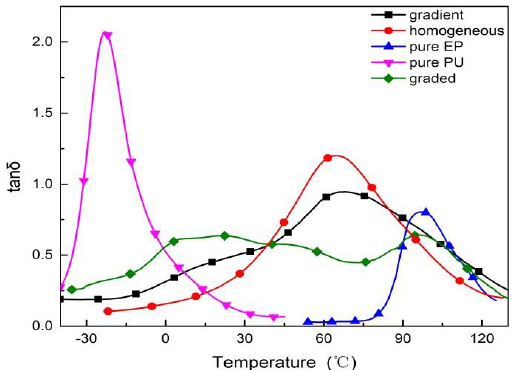
Figure 8. Damping curves of the EP, PU and the three kinds of IPN materials. Specimens were measured under the shear mode from −40 to 130 °C with a heating rate of 1.5 °C/min. Specimen dimension were Φ 8.79 mm × 2.17